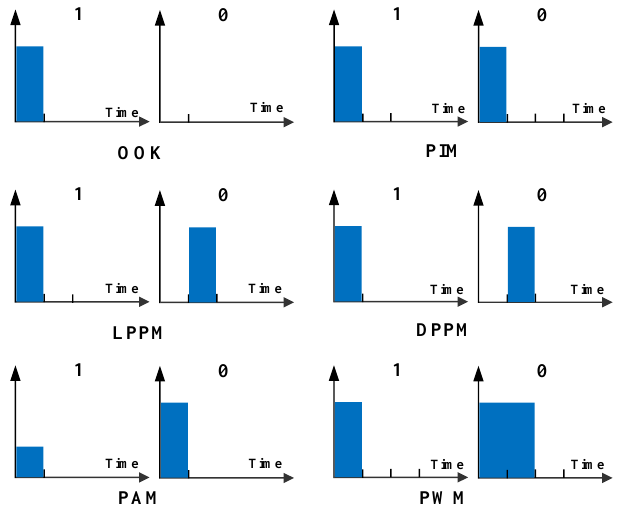
Figure 1. Symbol structure of several modulation modes of optical communication when M = 1 [37].